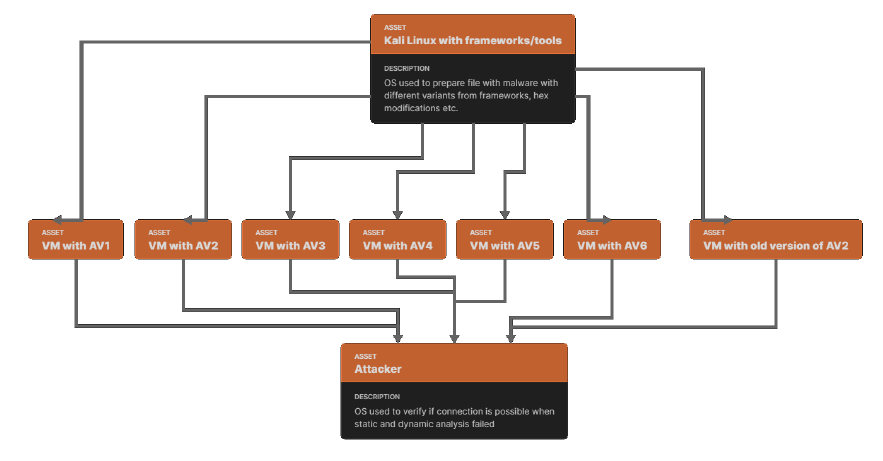
Figure 2. Dependencies between hosts in the created testing